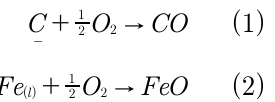
Figure 1: Diagram showing the formation of CO bubbles. Initially, oxygen is injected into the molten metal (step 1). This oxygen reacts with the existing carbon (equation 1), forming CO bubbles. The oxygen also reacts with the Fe present in the bath (equation